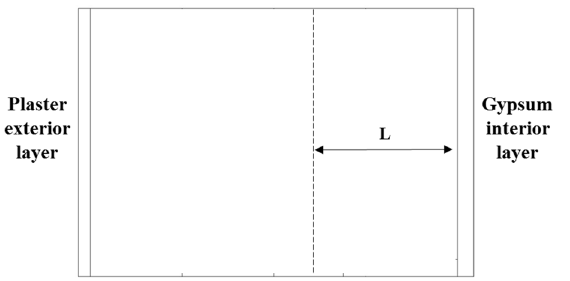
Figure 1. Wall geometry and design configurations, where HPCM is the layer with thickness L. Table 1. Thickness and thermophysical properties of the simulated materials [40,44]. Common Building